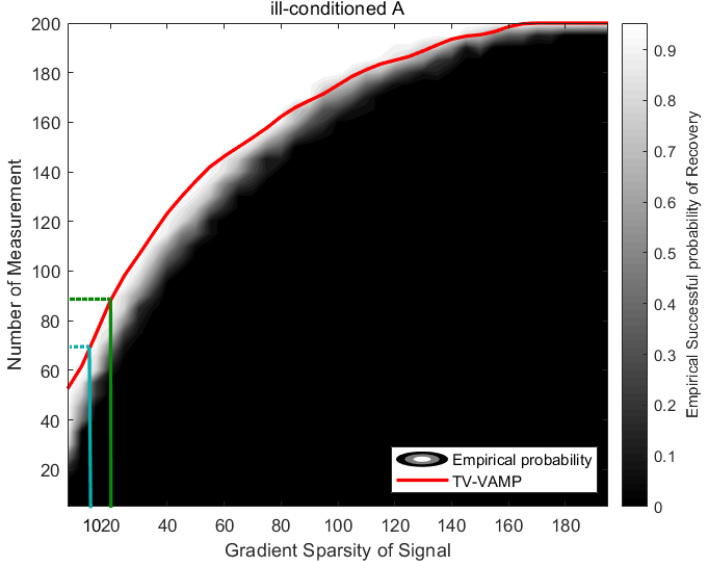
Figure 8. The figure shows phase transitions of CVX and TV-VAMP algorithm in the case of k ( A ) = 500 and n =